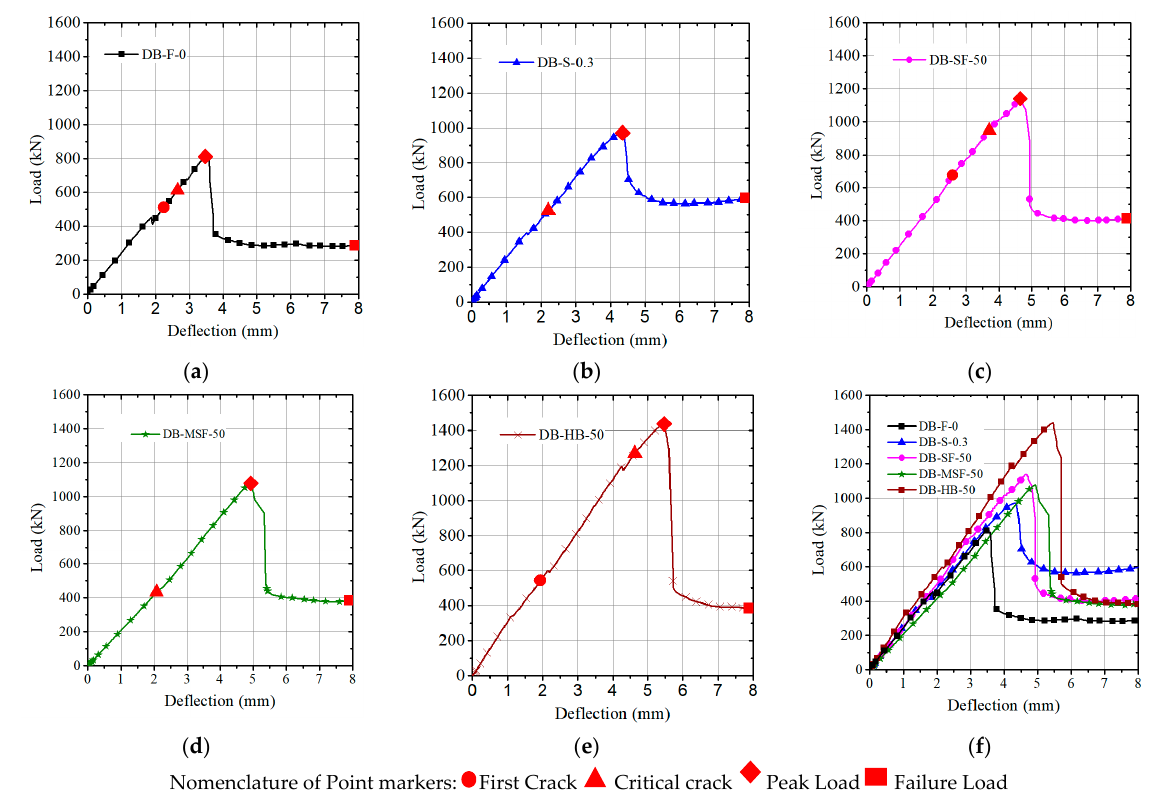
Figure 9. Load-deflection curves of tested specimens: ( a ) control beam ( b ) beam with web reinforcement ( c ) SF 50 beam ( d ) MSF 50 beam ( e ) hybrid 50 beam ( f ) summary.